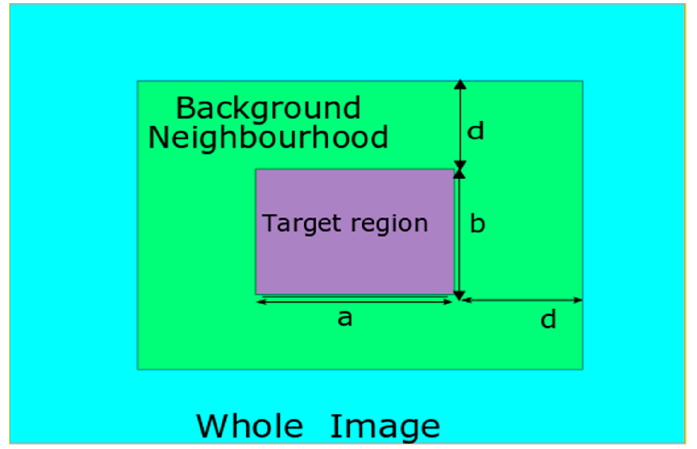
Figure 4. The infrared target and local background area.